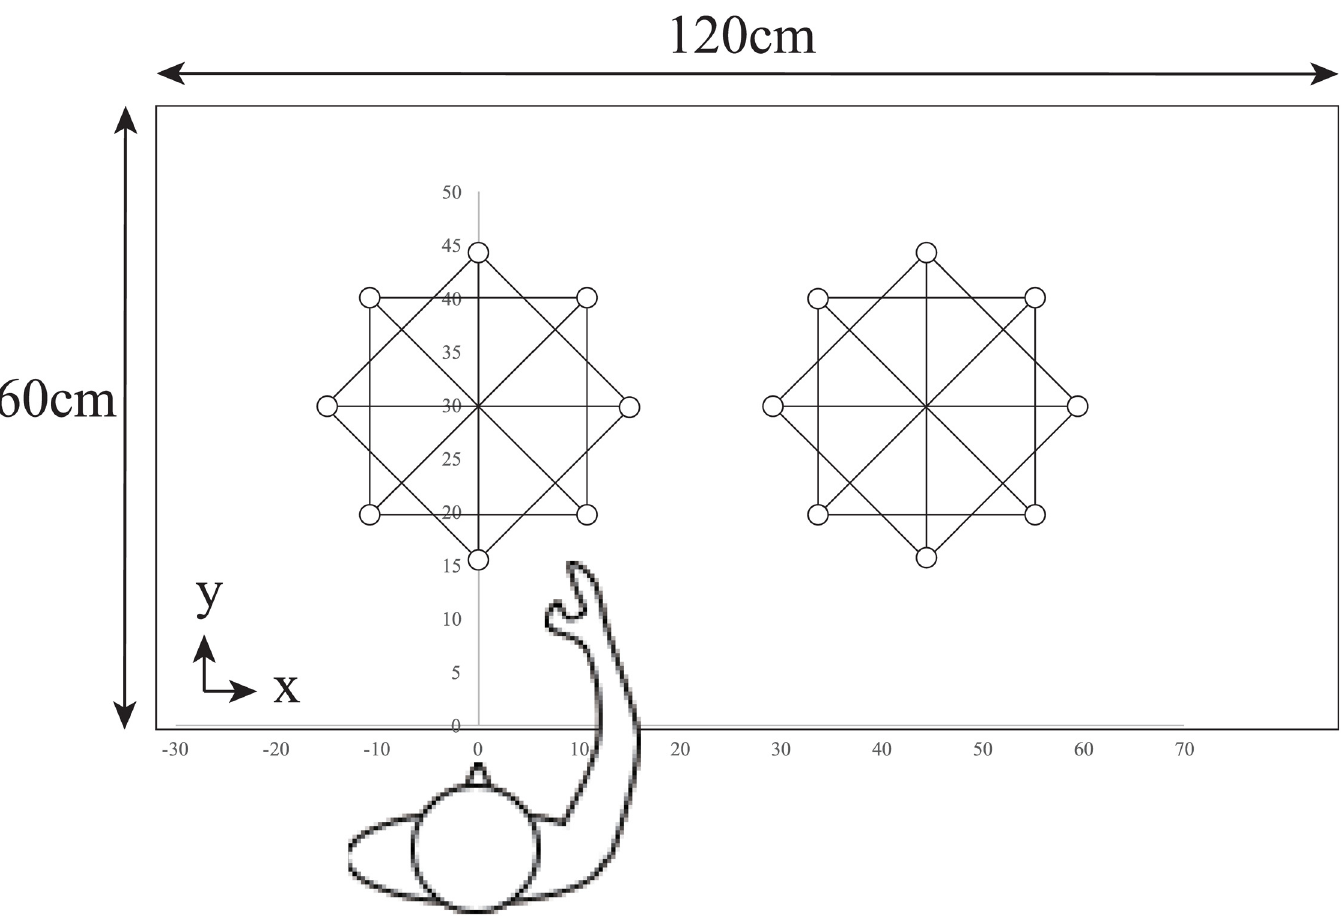
Fig 2. A schematic diagram of the experimental setup for the right handed group. The rectangle represents the table. The white circles depict possible places where magnets could be located. Three out of the eight positions were used to make an isosceles triangle. Participants wore eye masks throughout the